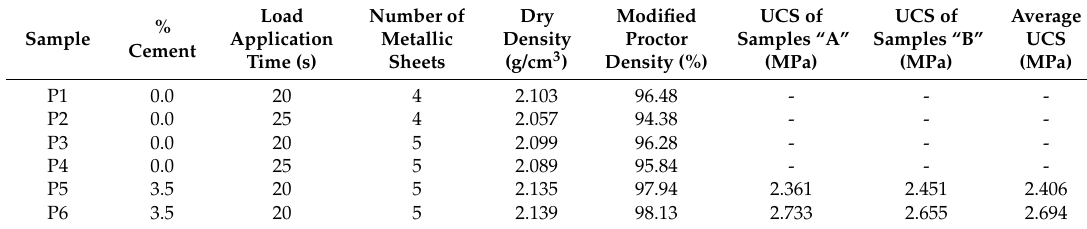
Table 3. Dry density and UCS values of prismatic specimens with 7% moisture